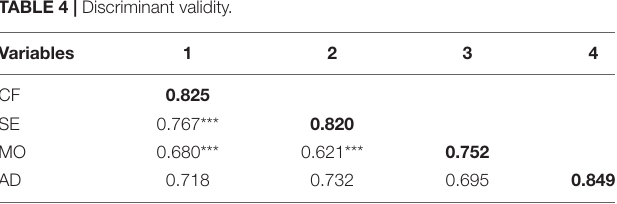
TABLE 4 | Discriminant validity.